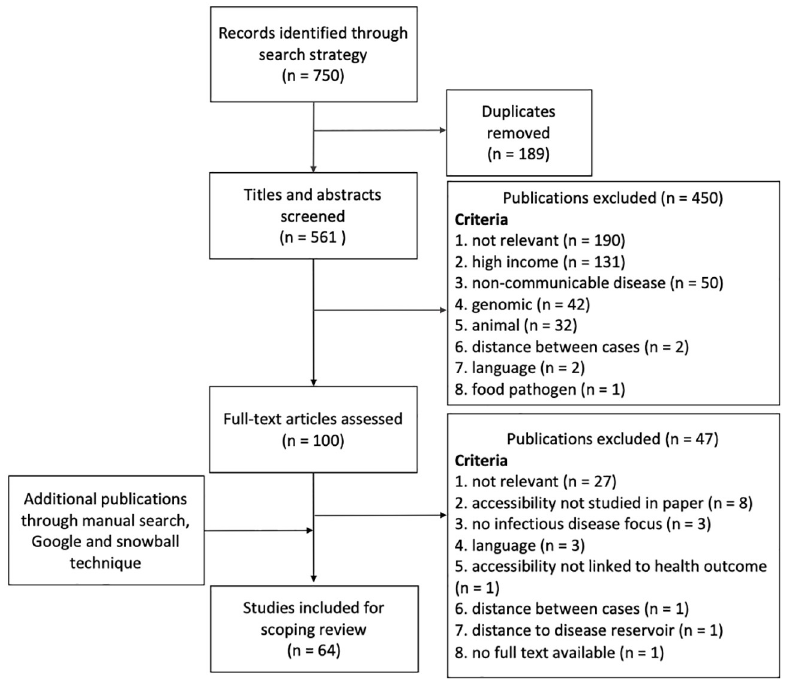
Fig 1. Overview of iterative article selection process and selected articles at each step.